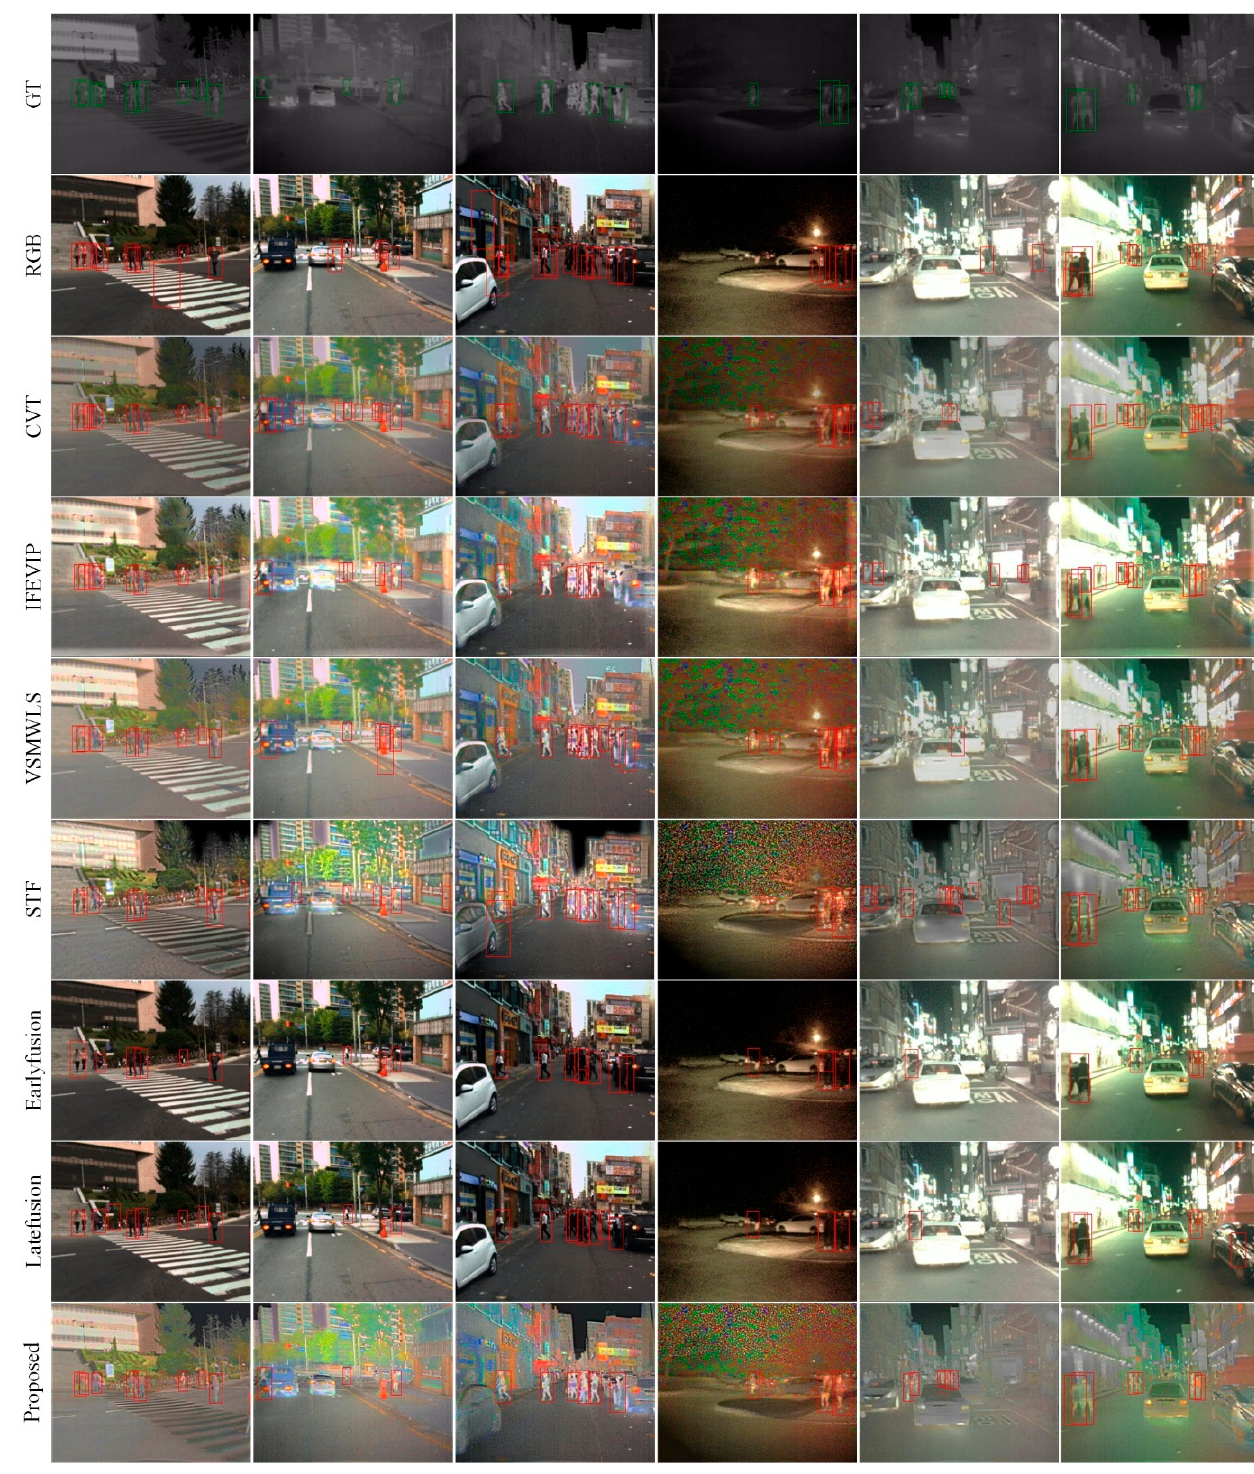
Figure 9. Qualitative comparation of the detection results via seven methods.